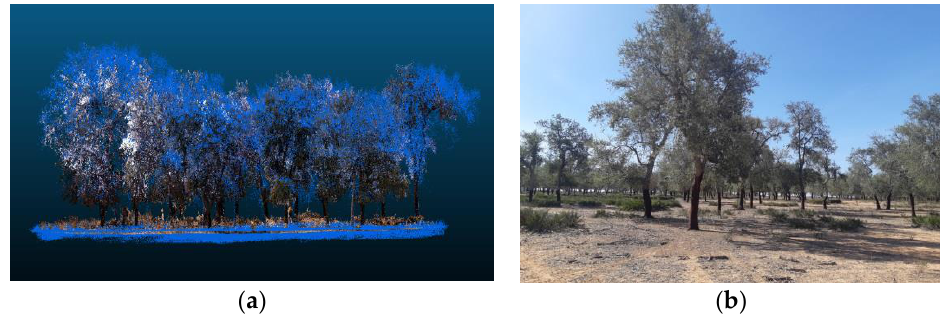
Figure 6. ( a ) 3D plot point cloud ALS-UAV-TLS in Maamora forest; ( b ) Cork oak stand in Maamora.